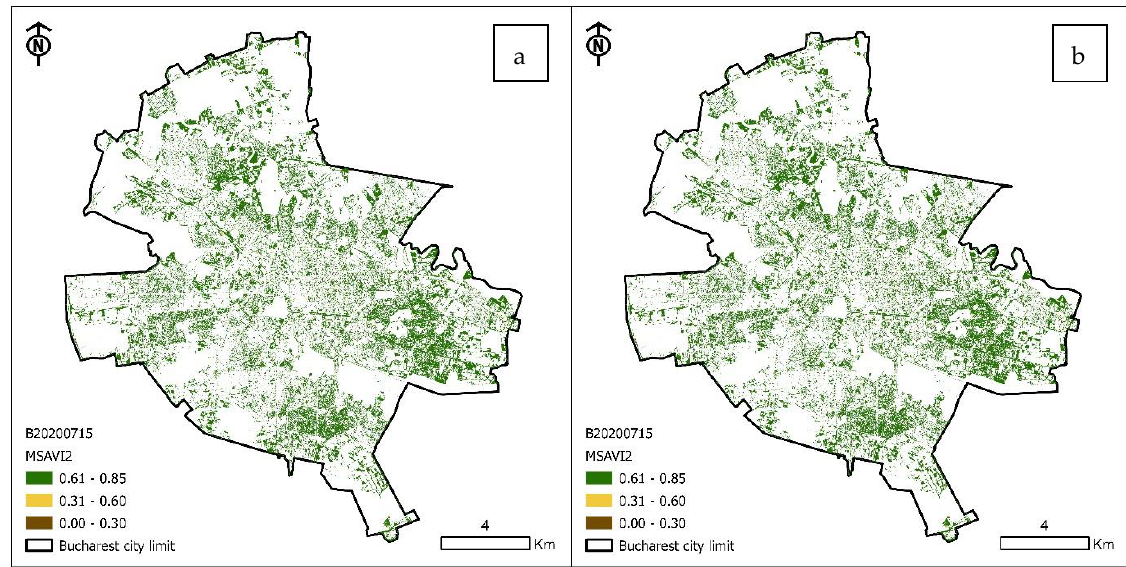
Figure 5. MSAVI2 distribution of small urban green areas for July 2020 in Bucharest ( a ) and Athens ( b ).